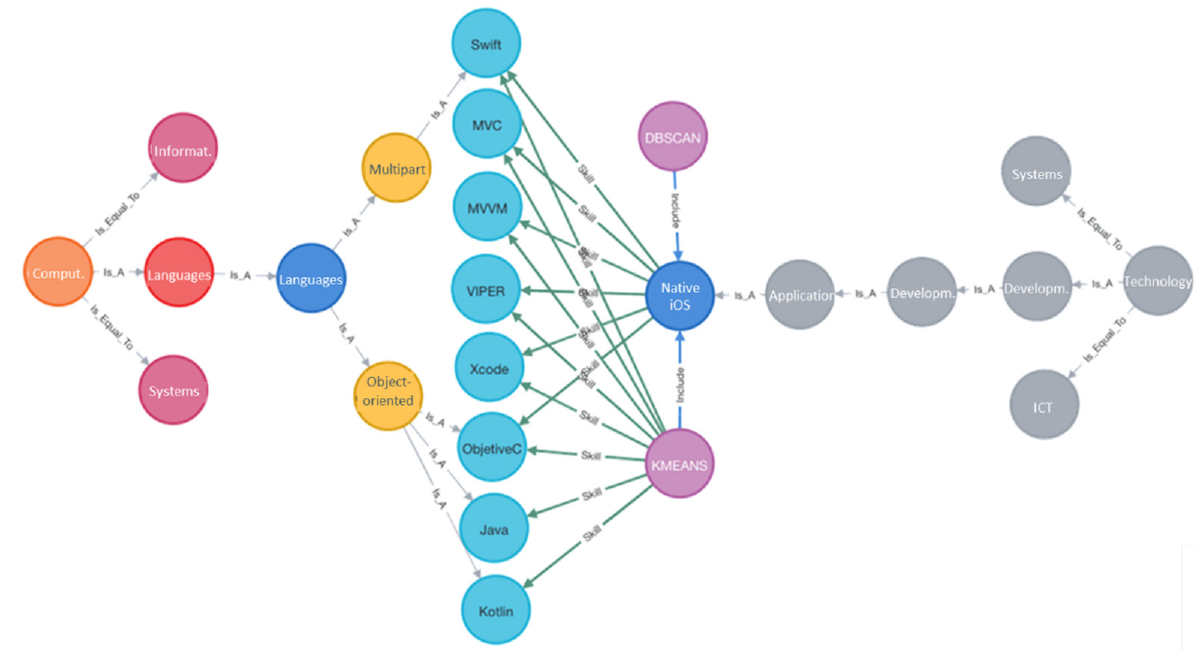
Figure 8. Extract from the knowledge graph.